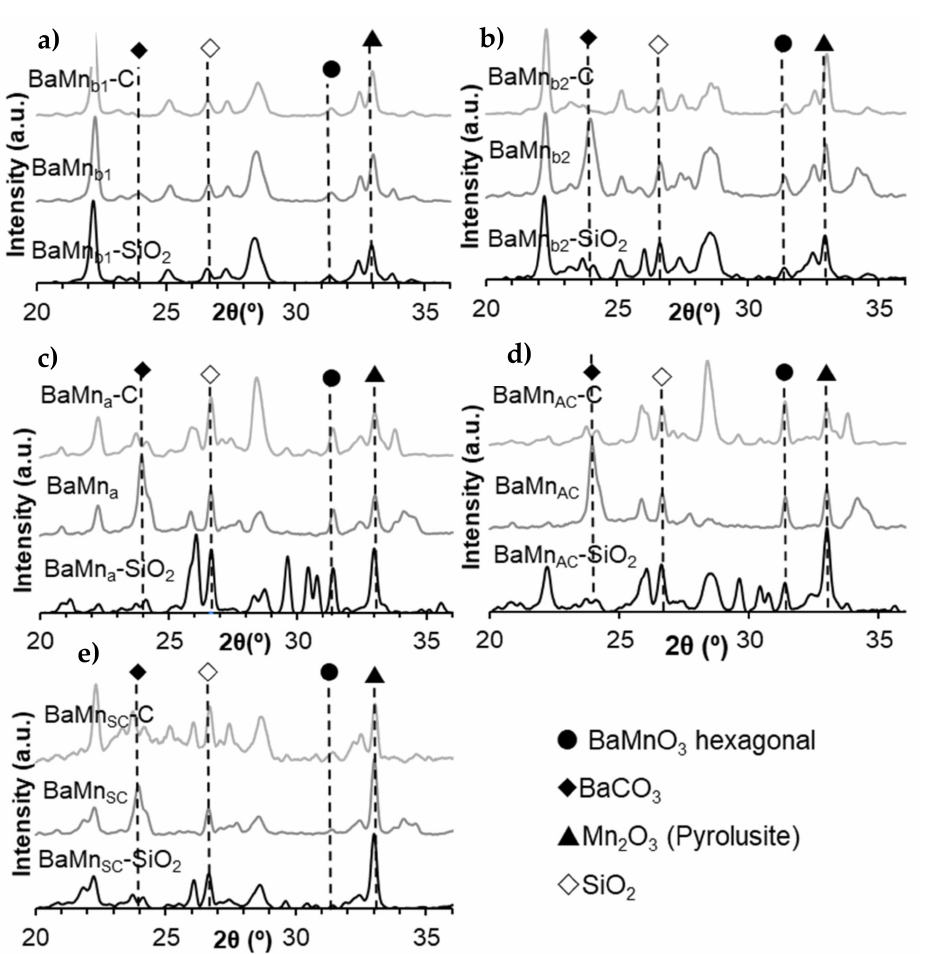
Figure A3. X–ray patterns of composites before (X-SiO 2 ), after silica removal (X) and after calcina- tion step (X-C) for the synthesis route indicated in Table A1: ( a ) BaMn b1 , ( b ) BaMn b2 , ( c ) BaMn a , ( d ) BaMn AC , and ( e ) BaMn SC